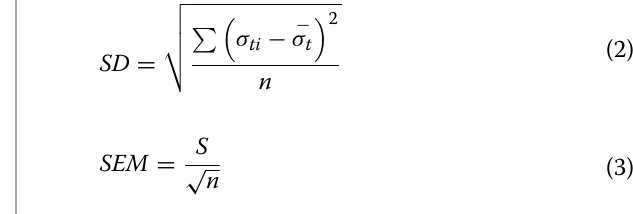
Table 2.where SD is the standard deviation and SEM is the standard error of the mean. These two parameters